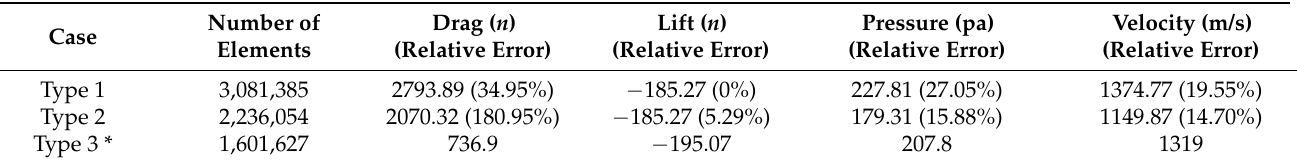
Table 1. Results from the grid convergence study performed on the model.